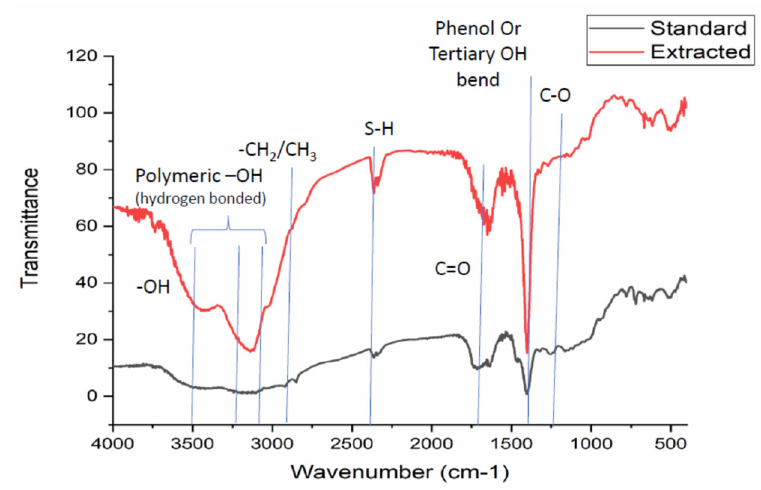
Figure 4. Comparison of FT − IR spectra of industrial standard lac resin and the lac resin recovered in the present study.